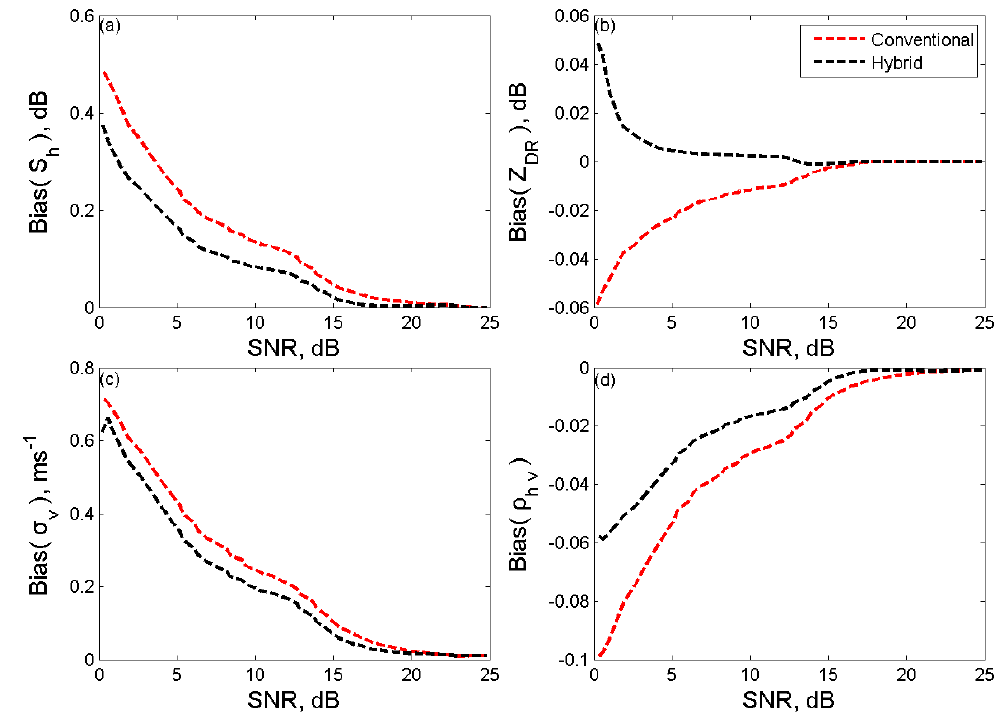
Figure 14. Biases of the hybrid method and conventional estimator for the PPI data of the squall line precipitation case. ( a ) S h ; ( b ) Z DR ; ( c ) σ v ; and ( d ) ρ hv . Remote Sens. 2019 , 11 , x FOR PEER REVIEW